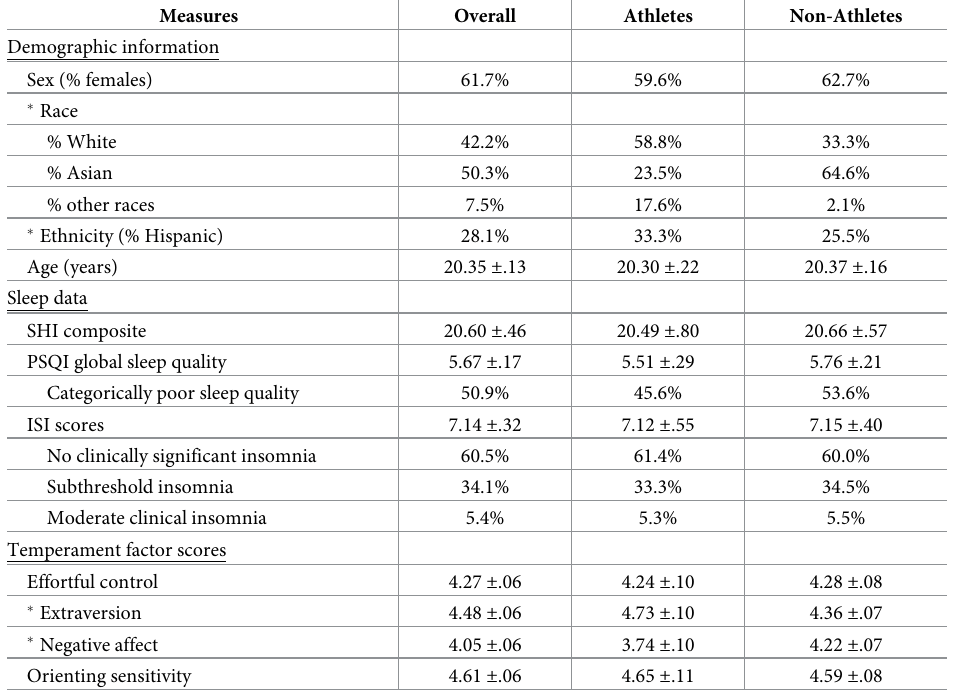
Table 1. Examination of group differences for athletes and non-athletes (N =